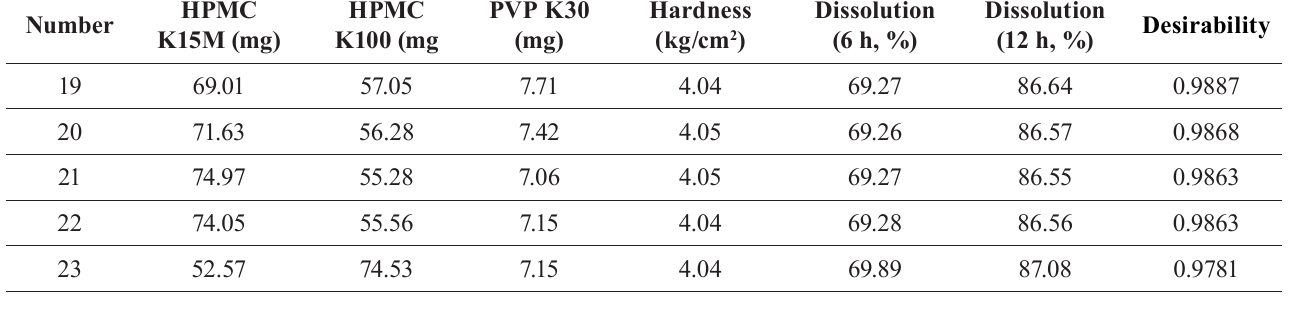
TABLE VI - Results of desirability function analysis